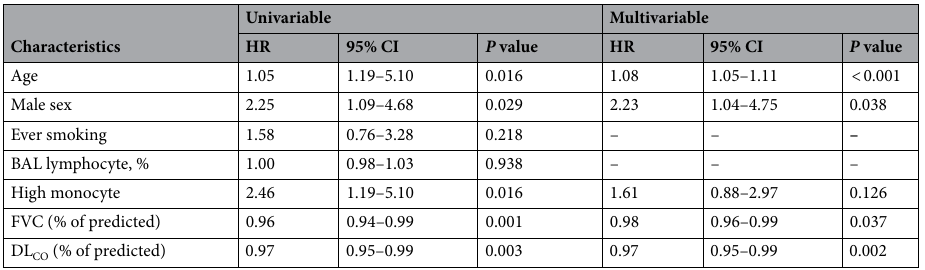
Table 4. Cox proportional hazard analysis of mortality in patients with idiopathic nonspecific interstitial pneumonia. HR, hazard ratio; CI, confidence interval; BAL, bronchoalveolar lavage fluid; FVC, forced vital capacity; DL CO , diffusing capacity of the